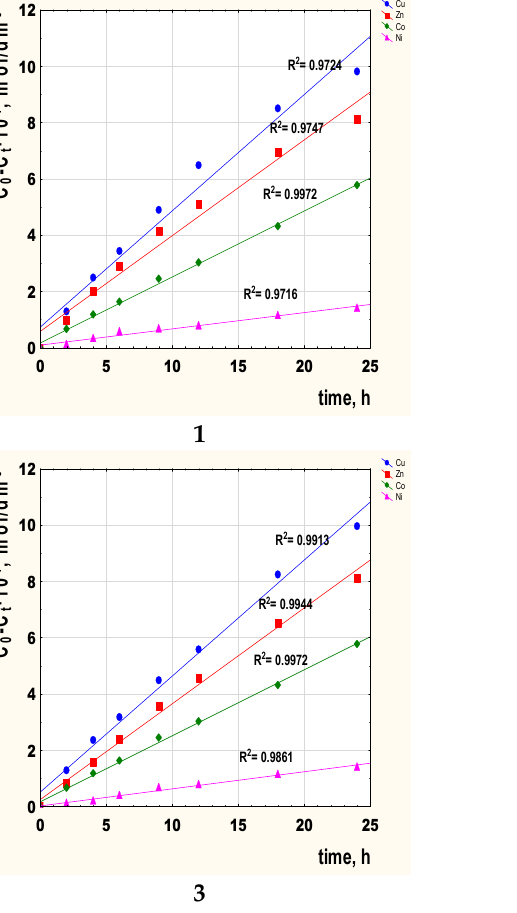
Table 5. Diffusion coefficients (Do) of Cu(II), Zn(II), Co(II), and Ni(II) complexes with 2- alkylimidazoles and membrane diffusion resistance values ( Δ o ).